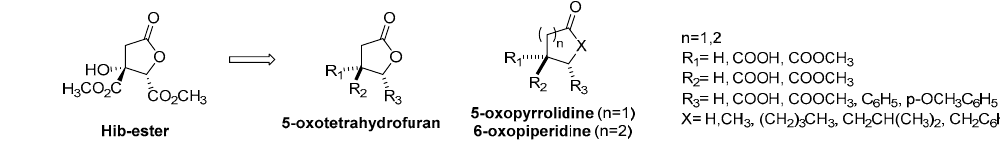
Figure 1. Chemical modification around Hib-ester